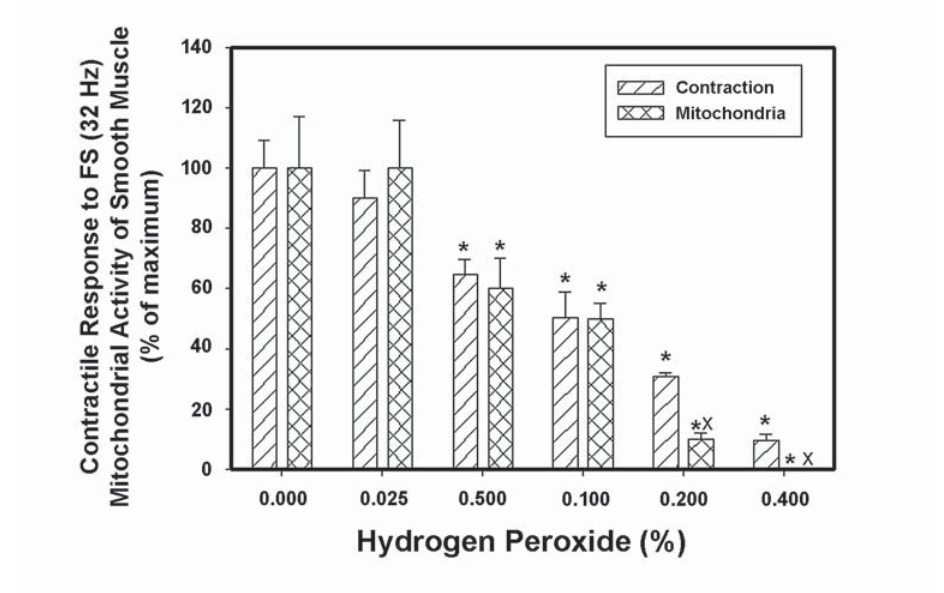
Figure 1 – Comparison of the effect of H2O2 on contraction and citrate synthase activity (muscle). Each bar is the mean ± SEM of 6 individual